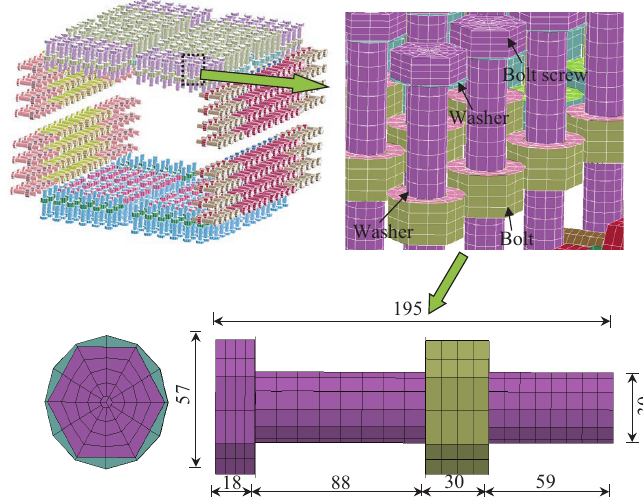
Figure 6. The details of the bolt